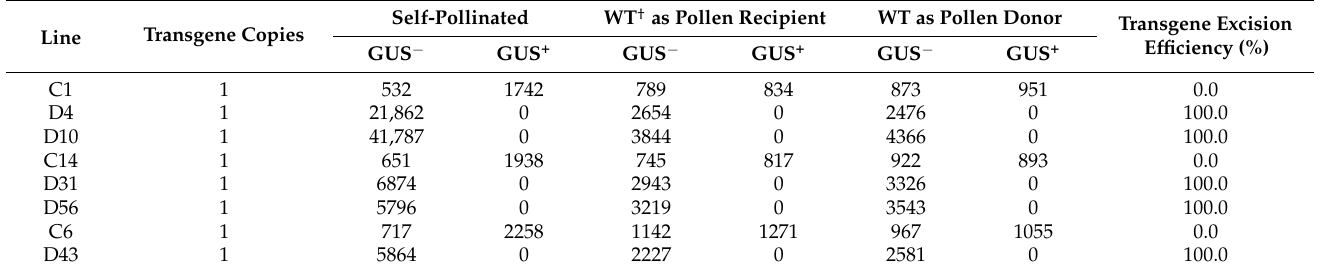
Table 2. Transgene excision efficiency in the pollen and seeds of transgenic plants grown in a green- house; transgene excision efficiency was determined based on GUS staining of the T1 seedlings. Lines C1, C14, and C6 (control lines); lines D4, D10, D31, D56, and D43 (lines with “Gene Deletor” cassette).